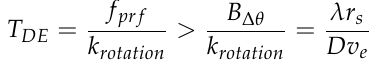
Figure 4. The value range of azimuth signal after a derotation operation, which is limited by Equation (14) (black solid rectangular window), Equation (17) (red dashed rectangular window), and Equation (18) (blue dash-dot rectangular window).